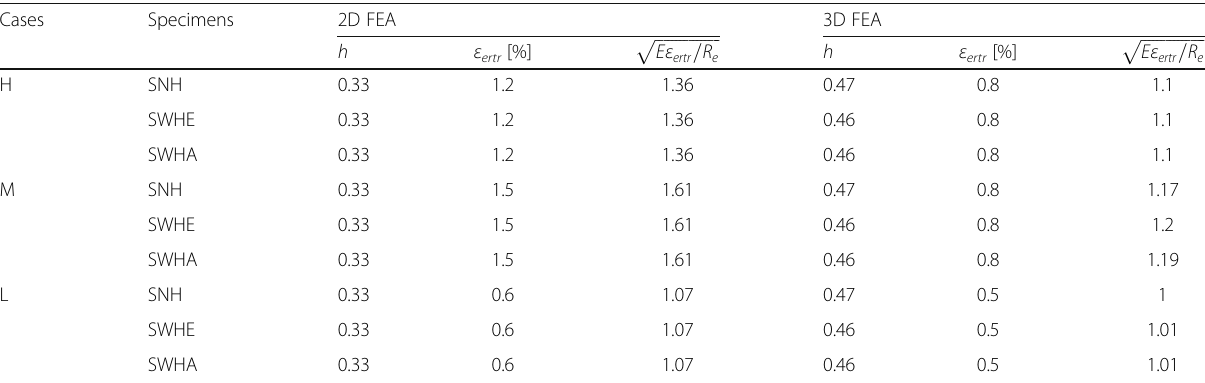
Table 9 Degree of multiaxiality h , critical value of total strain ε ertr and factor